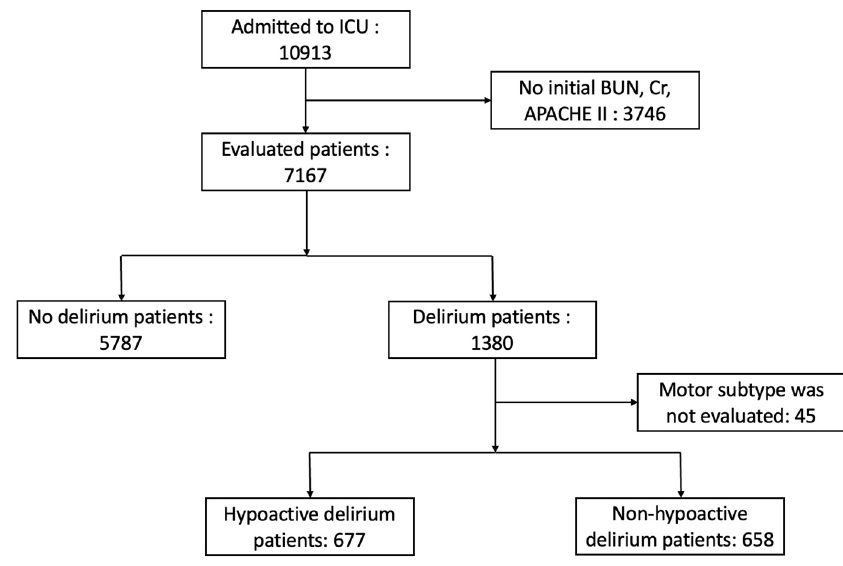
Figure 1. Flowchart depicting the inclusion